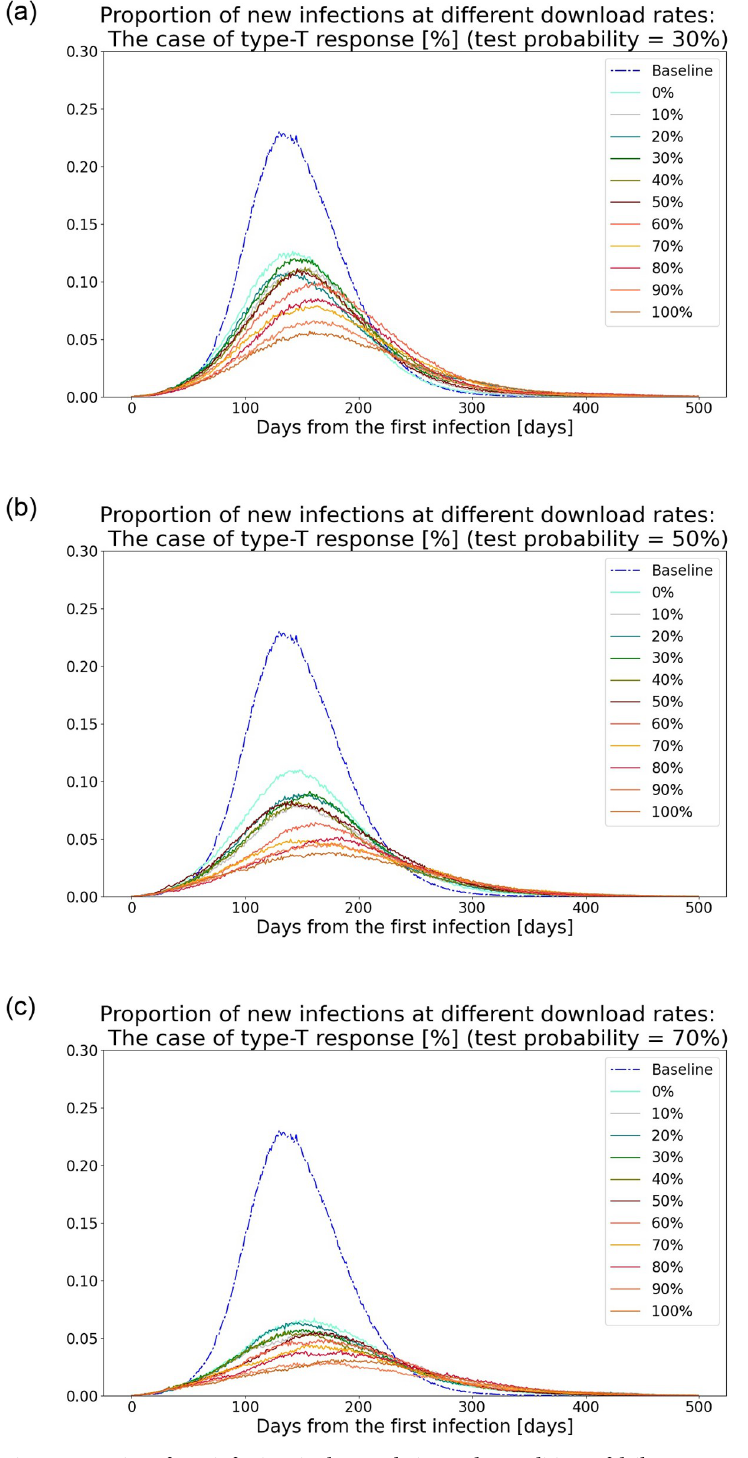
Fig 1. Proportion of new infections in the population under conditions of daily tests on randomly selected symptomatic people: Type-T response. (a) Scenario of 30% test probability. (b) Scenario of 50% test probability. (c) Scenario of 70% test